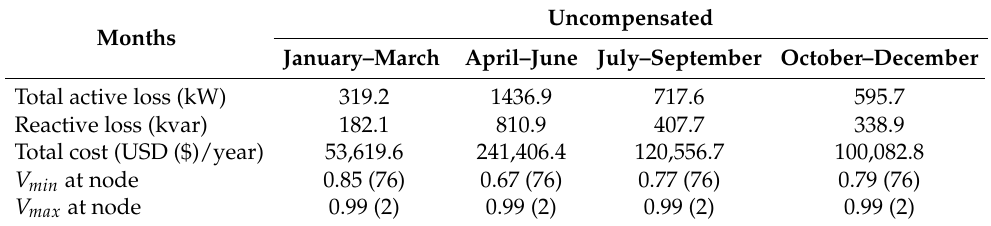
Table 5. Base data (uncompensated) of N 2 for CS 2